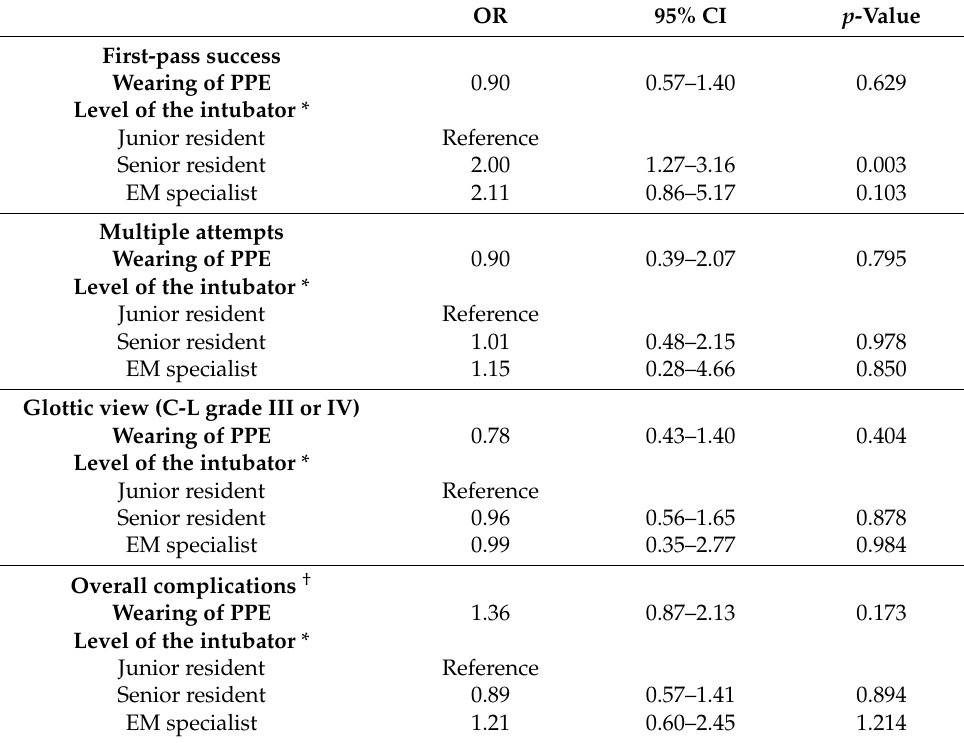
Table 3. Relationships between outcomes and the use of PPE among the propensity-score-matched groups. OR 95% CI p